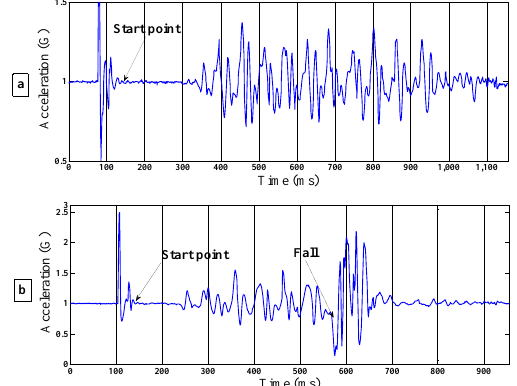
Fig. 4. a. Sample of walking acceleration signal, b. Sample of fall forward acceleration